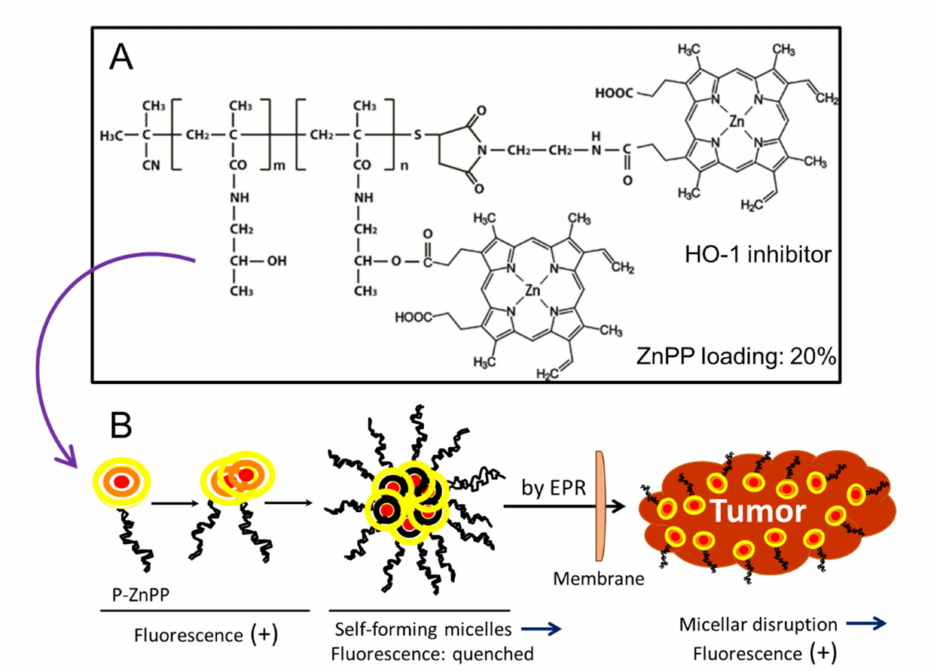
Figure 3. Self-assembling PS polymer conjugates of HPMA and ZnPP. ( A ) Chemical structure of the HPMA-PS polymer conjugate. ( B ) Polymer-ZnPP in solution. Spontaneous micelles were formed. Quenching occurs in the self-forming micellar form of P-ZnPP, which leads to a lack of fluorescence in the micellar form. When tumor cells take up these micelles, the micelles disintegrate during the traversing lipid bilayer due to its amphiphilic nature. Then, fluorescence becomes positive and singlet oxygen (ROS) are generated in the tumor upon light irradiation ( B ). ZnPP itself also inhibits heme oxygenase-1 (HO-1) and suppresses tumors (see text for